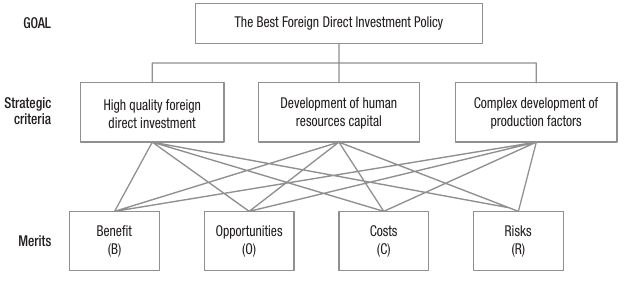
Fig. 1. The control hierarchy Source : compiled by the